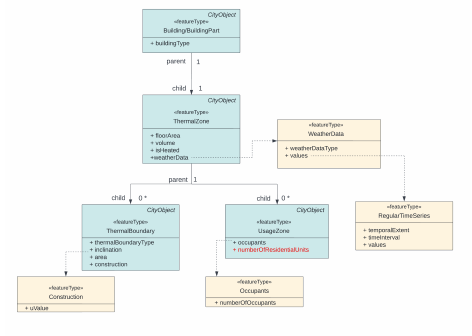
Figure 8. Used objects and attributes to store the required input data in the CityJSON + Energy Extension file